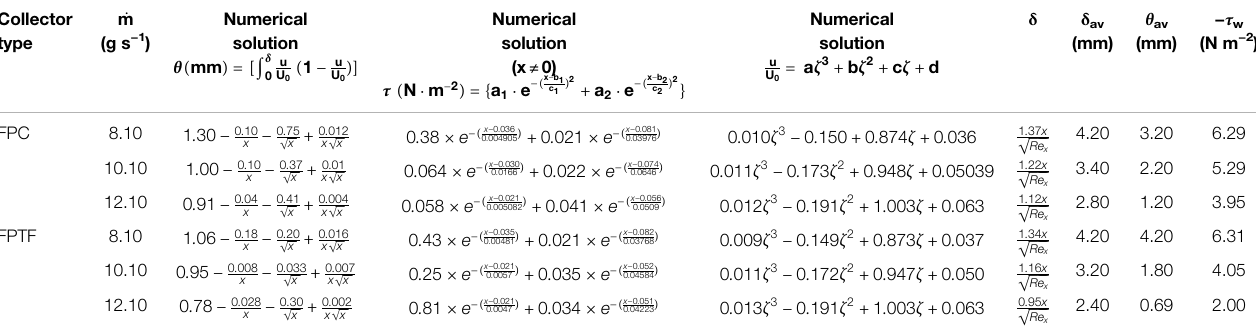
TABLE 4 | The change in the velocity pro fi le ( u ), momentum thickness ( θ ), and wall steer stress ( τ w ) with the stretching factor ( ζ ) and length of a collector ( x ), respectively. Collector